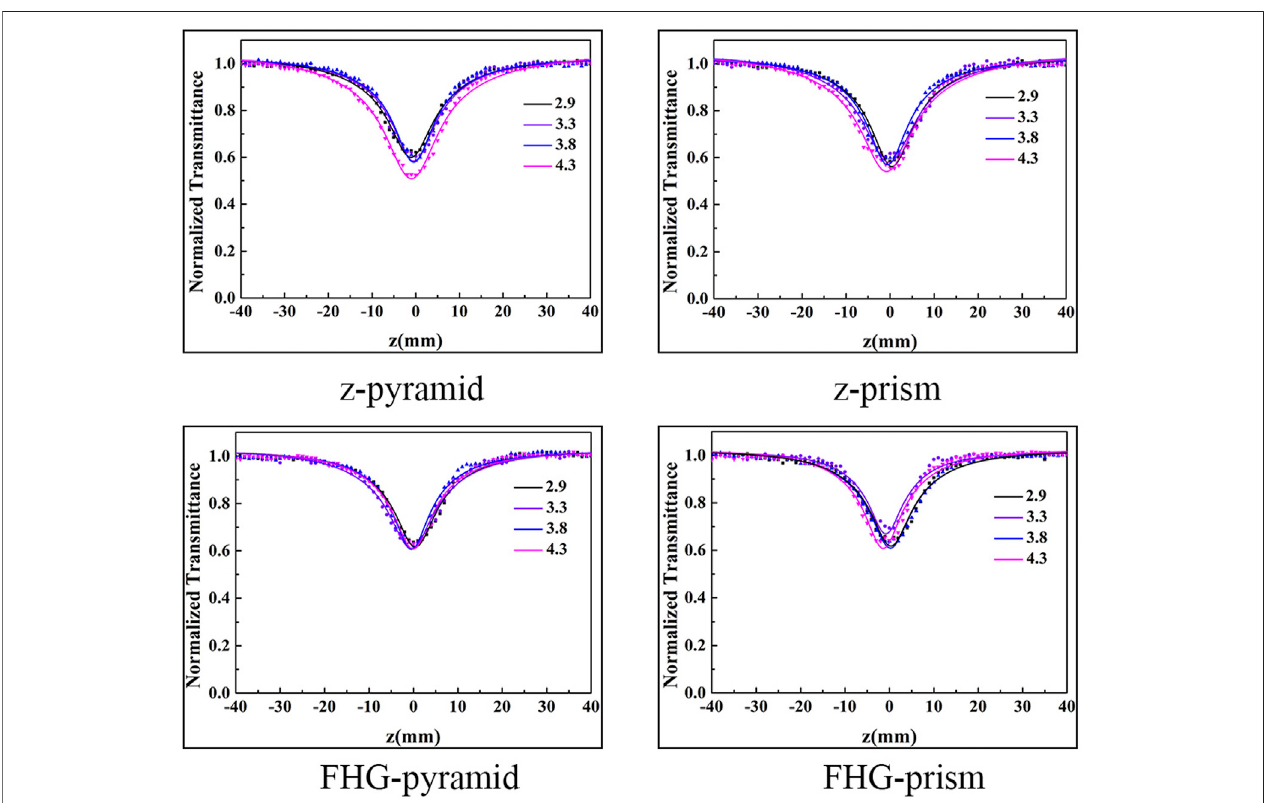
FIGURE 9 | The NLA curves of samples with an I 0 of 22 GW/cm 2